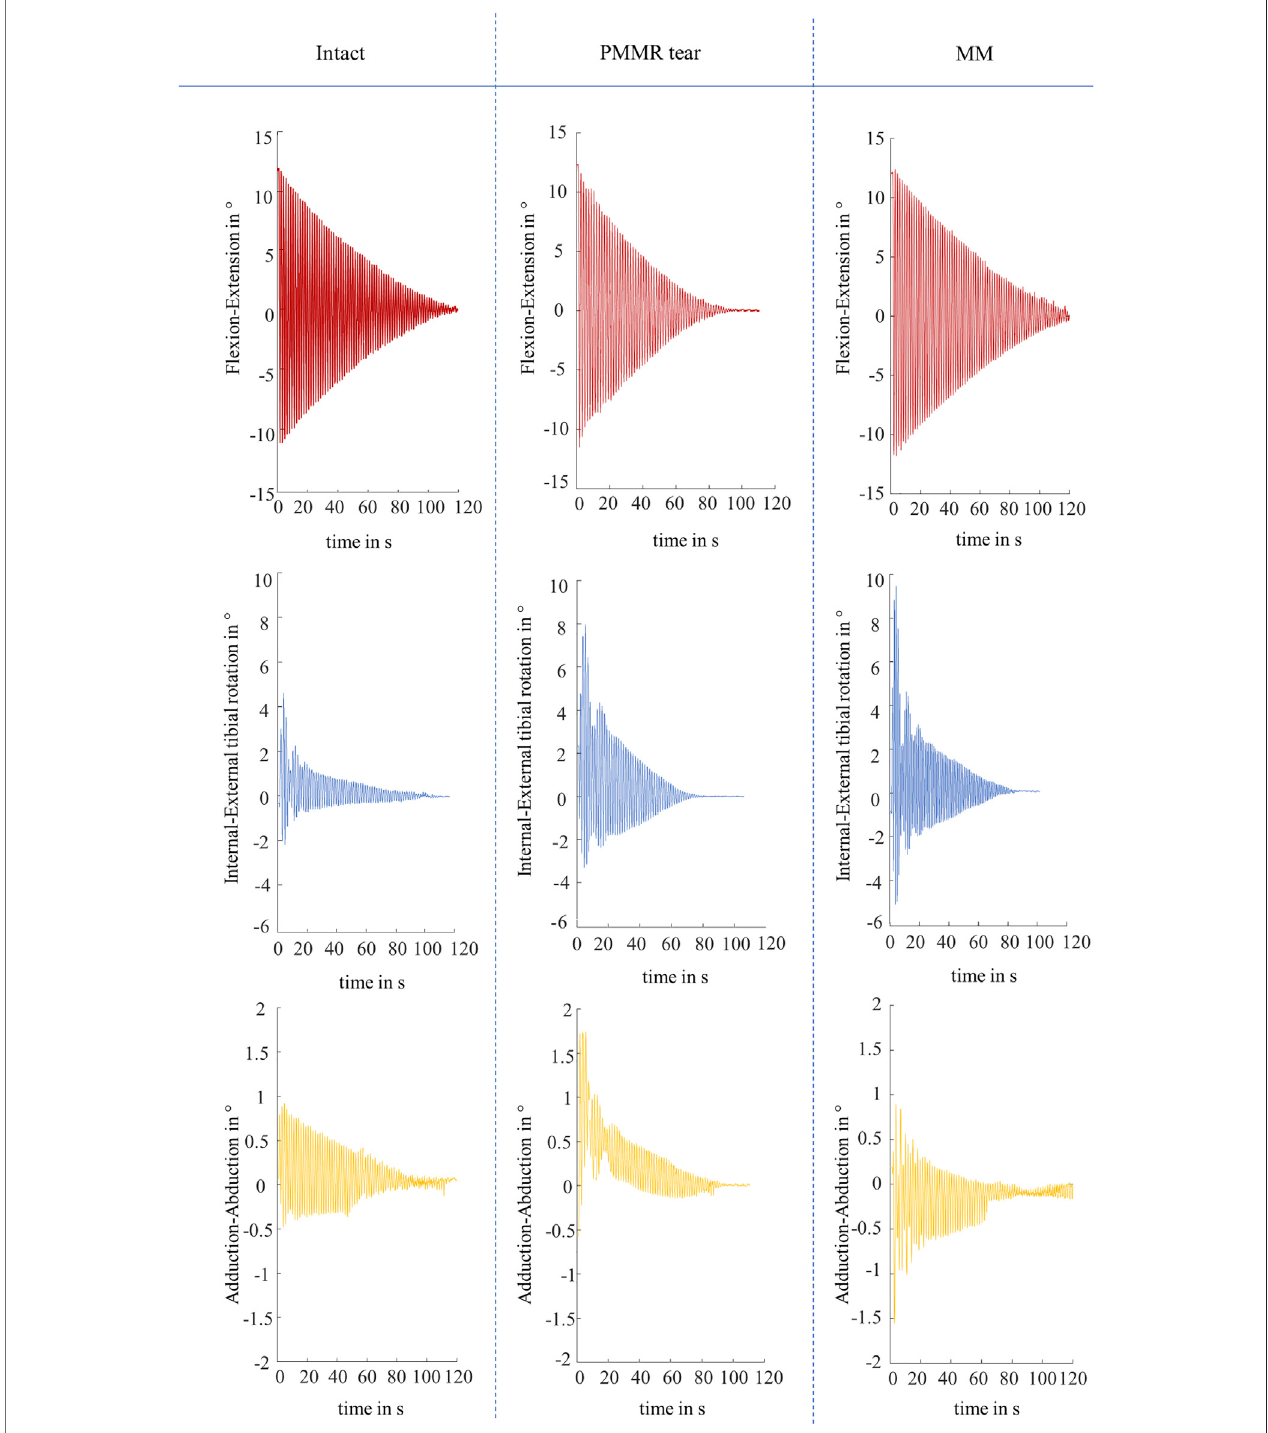
FIGURE 5 | Representative kinematic plots of one knee in fl exion-extension in ° (red), internal-external tibial rotation in ° (blue) and adduction-abduction in ° (yellow) according to Grood and Suntay (Grood and Suntay, 1983) under swing phase conditions for the three meniscus states of intact, after simulation of a posterior medial meniscus root tear (PMMR tear) and after medial meniscectomy (MM).